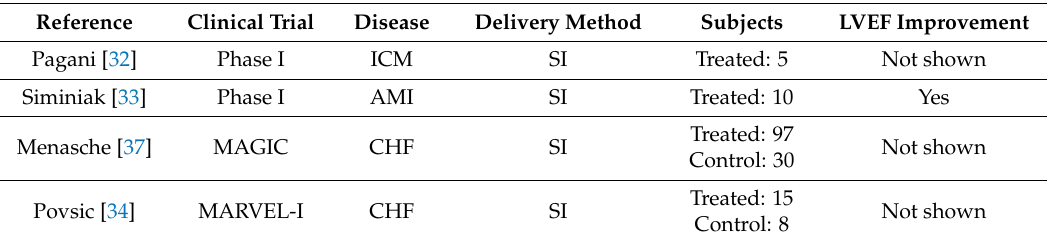
Table 1. Clinical trials with committed cells (skeletal myoblasts) for cardiac regeneration. Reference Clinical